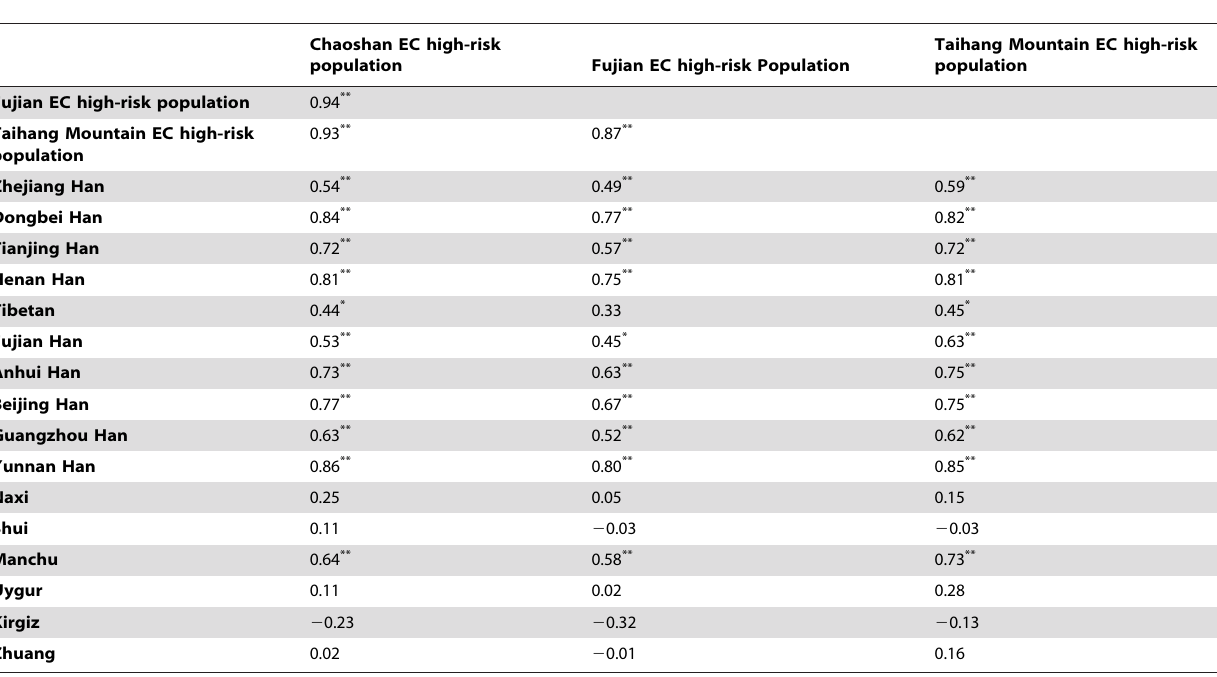
Table 3. Correlation analyses of Y- short tandem repeat (Y-STR) haplotype frequencies of the 3 EC high-risk populations, 9 Chinese Han populations, and 7 Chinese minority nationalities.